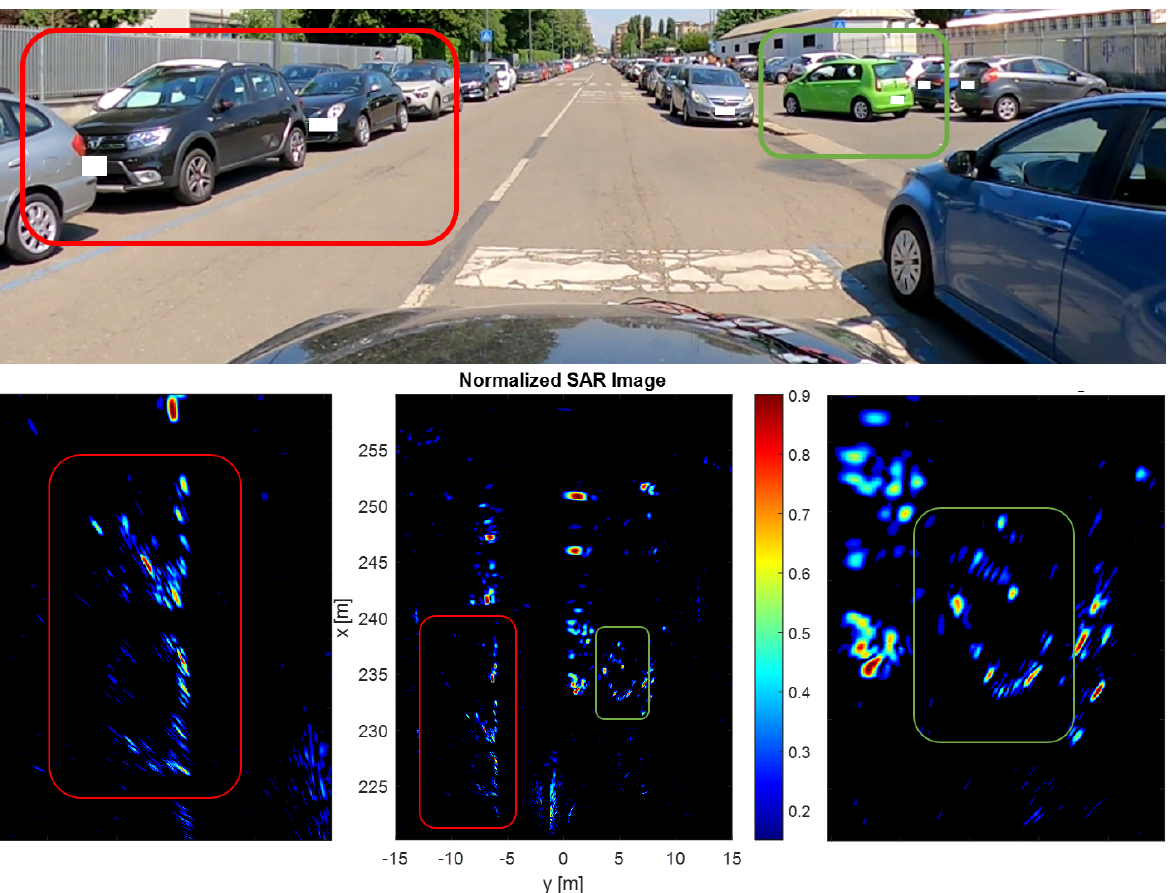
Figure 14. ( top ) Optical image of the field of view. ( bottom central ) SAR image of the entire scenario. ( bottom right ) A detail of the full SAR image: the green car in the optical image is parking. ( bottom left ) Another detail: some parked cars to the left of the